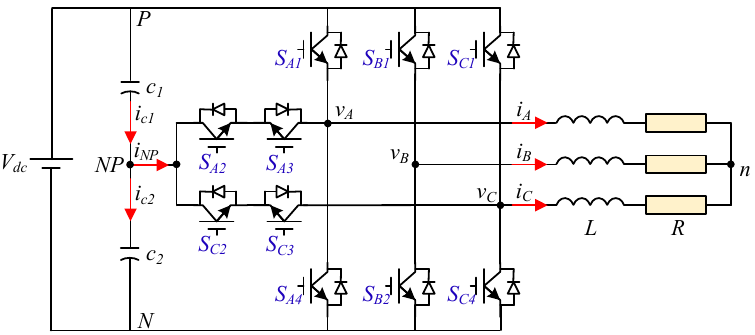
Figure 2. The topology of asymmetric T − type NPC 3 − level Inverter.